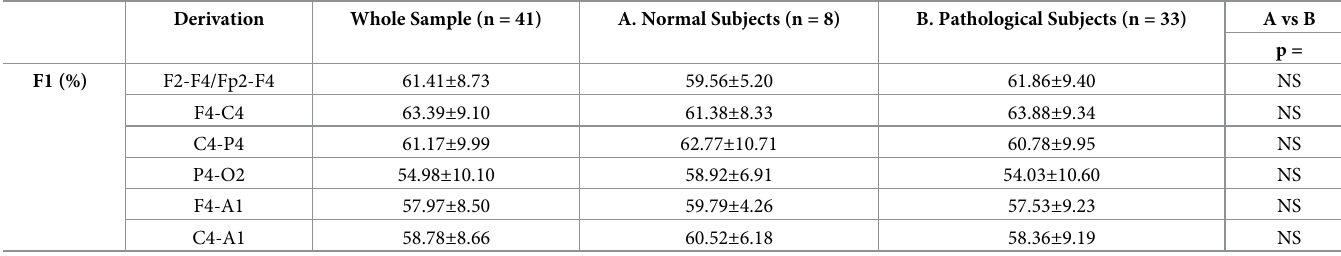
Table 3. F1—performance metric.